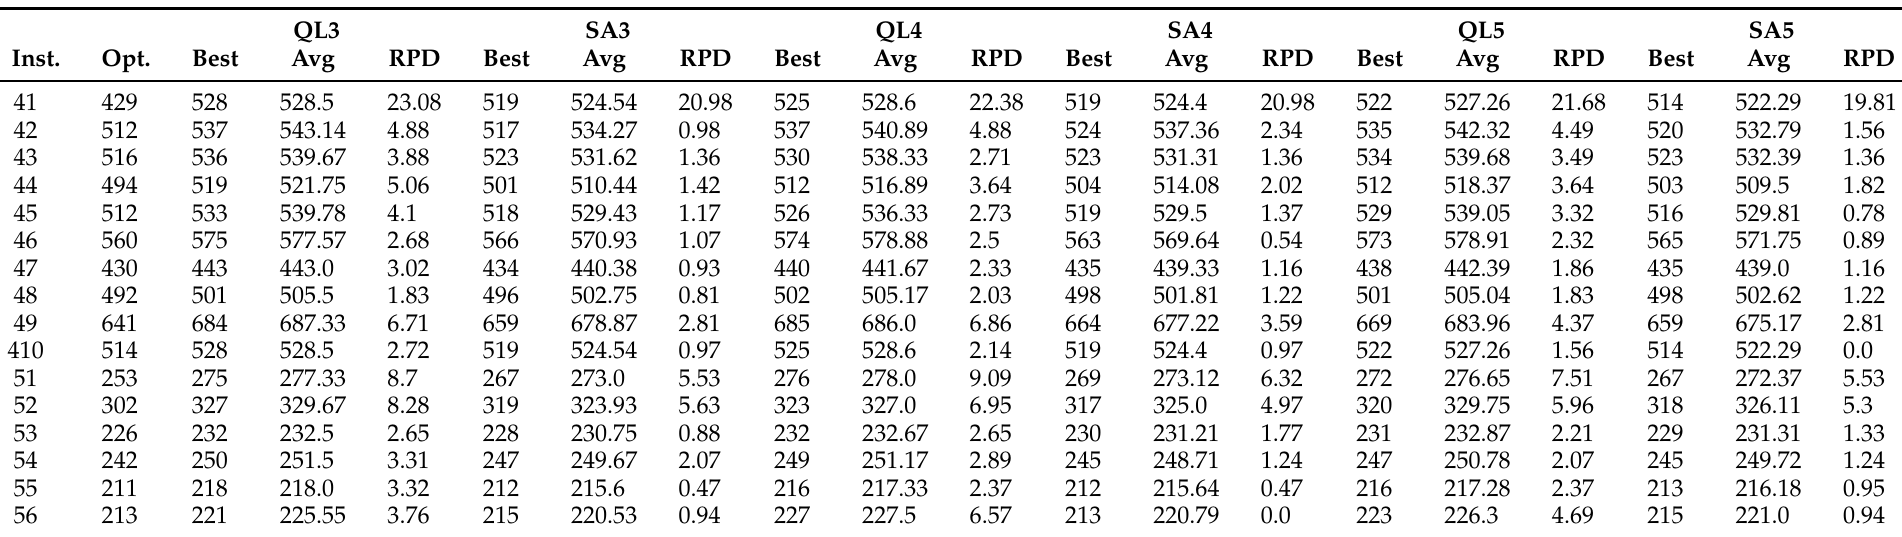
Table 14. Result comparison with HHO employing the approaches QL3, SA3, QL4, SA4, QL5, and